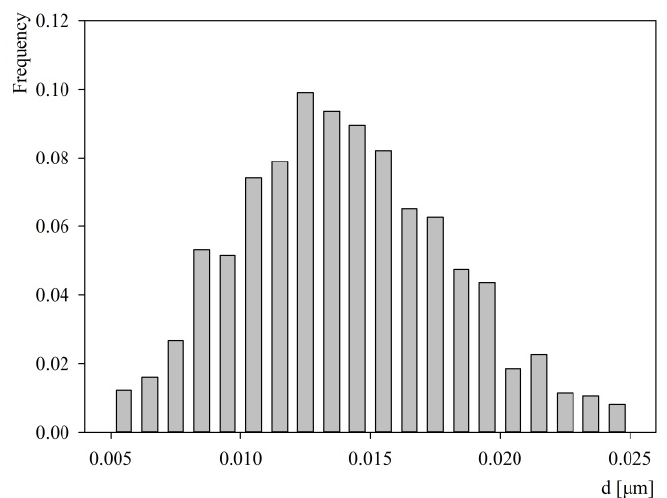
Figure 6. Histogram of the S1R protein size at mica determined by AFM; pH 5.6, c b = 2 mg L − 1 , 150 mM NaCl, adsorption time 15 min. Average aggregate size 14 ± 4 nm.